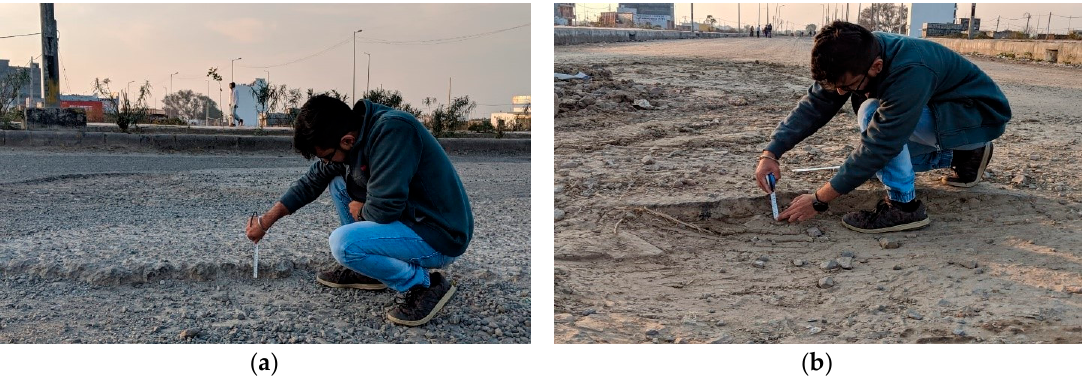
Figure 9. Manual inspection on a rough patch in the middle of R1 ( a ) and R2 ( b ). Table 7. Information of pothole (P) and bumps (B) collected by manual inspection for the R1 test site. Scenario No.